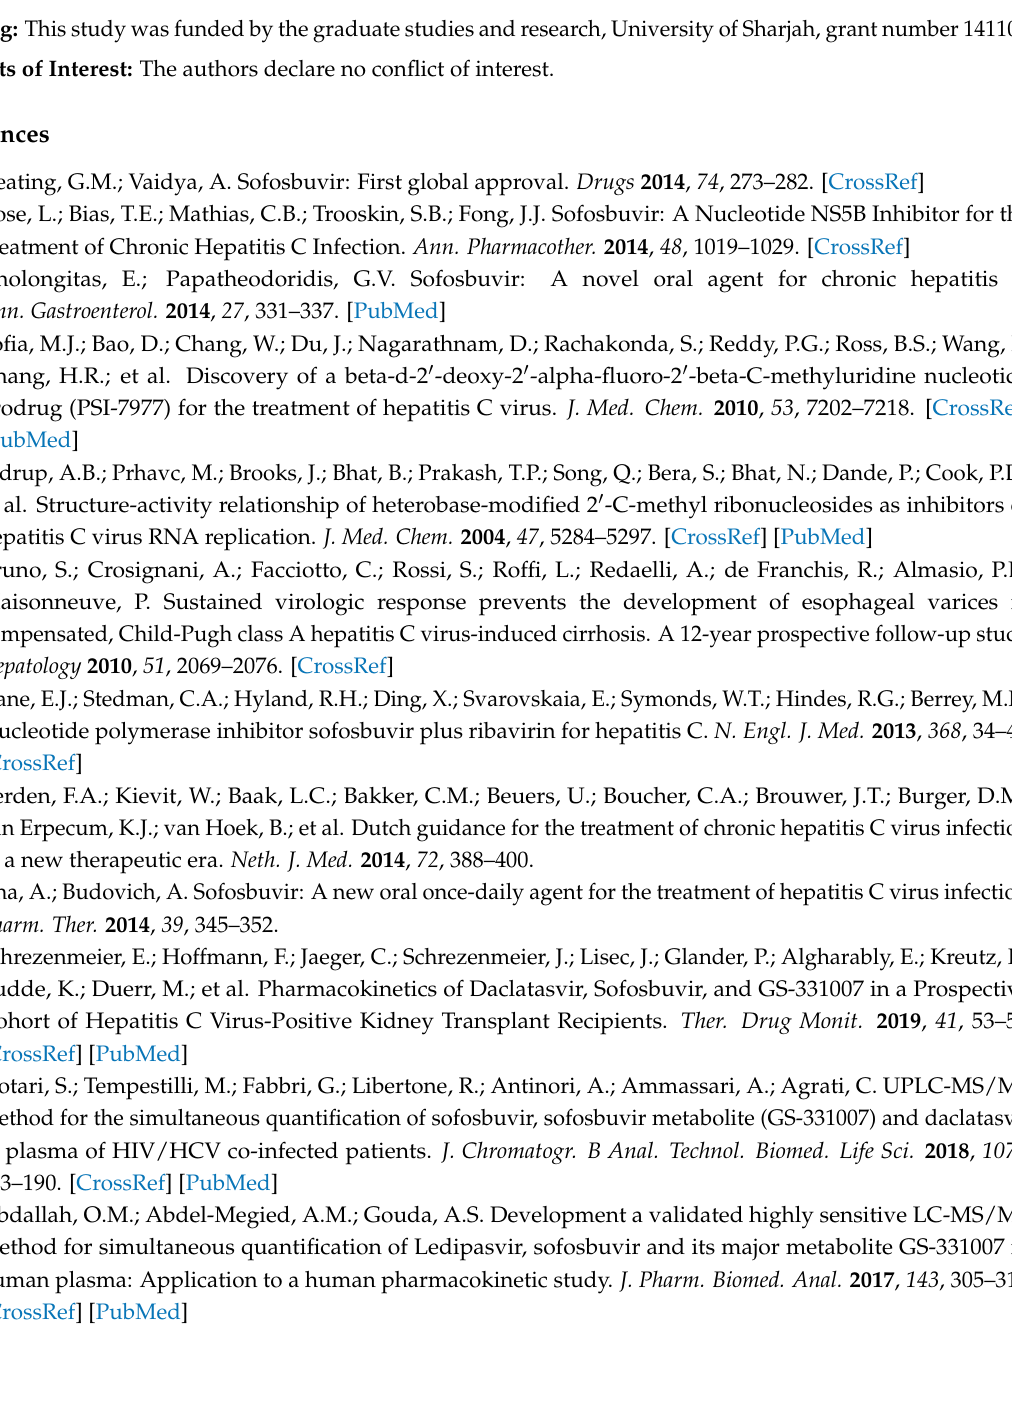
s1, Figure S1: The effect of ammonium acetate on peak shape and symmetry, Figure S2: Methanol effect on the retention